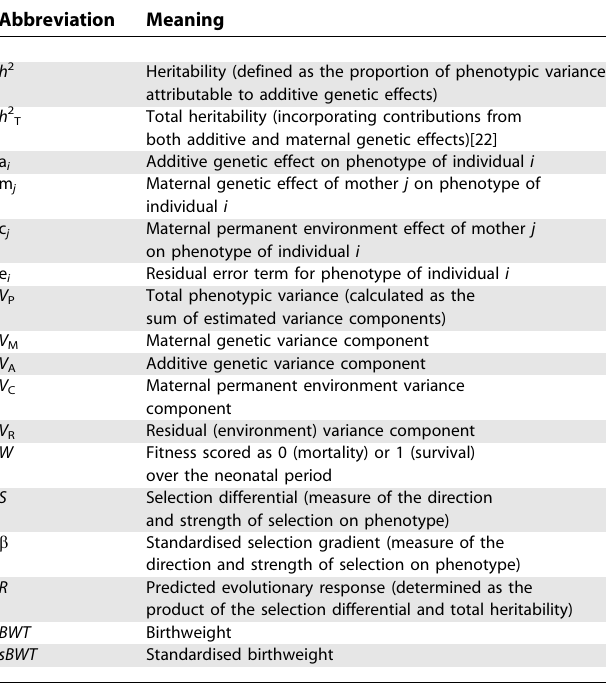
Table 1. Glossary of Terms and Abbreviations Used in Quantitative Genetic